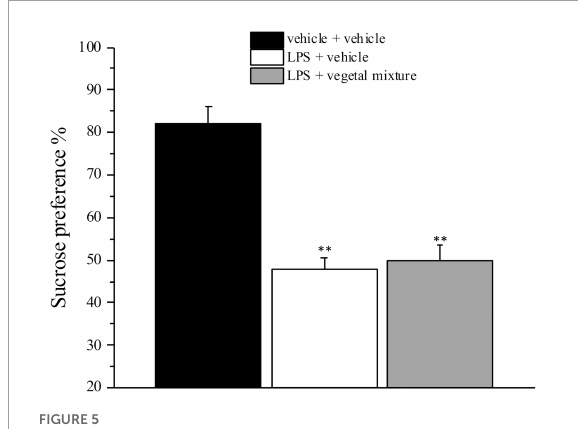
FIGURE5 Effect of a vegetal mixture on LPS-induced anhedonia. LPS (1 mg kg - 1 ) was intraperitoneally injected on days 1, 3, 5, and 8. The vegetal mixture was composed of Zingiber officinale (150 mg kg - 1 ), Echinacea purpurea (20 mg kg - 1 ), and Centella asiatica (200 mg kg - 1 ), suspended in 1% carboxymethylcellulose sodium salt (CMC) and orally administered daily starting from day 1 till the end of the experiment. Control animals were treated with vehicles. Starting from day 9 and 24 h after the last administration of the vegetal mixture, anhedonia was assessed by the Sucrose preference test. Data are expressed as the mean ± SEM of values from eight mice analyzed in two different experimental sets. ∗∗ p < 0.01 vs. vehicle +